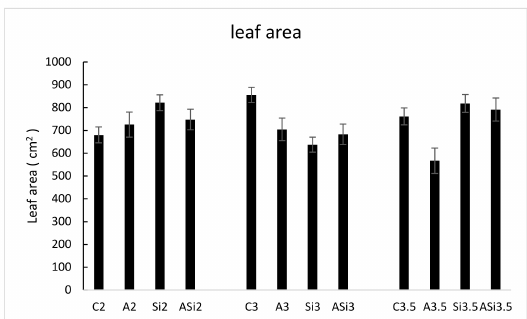
Figure 10. Leaf area at the end of the trial for the C2 (foliar application with water and fertigation EC 2.0 dS m − 1 ), A2 (foliar application with Arthrospira platensis and fertigation EC 2.0 dS m − 1 ), Si2 (foliar application with Si and fertigation EC 2.0 dS m − 1 ), ASi2 (foliar application with Arthrospira platensis and Si and fertigation EC 2.0 dS m − 1 ), C3.0 (foliar application with water and fertigation EC 3.0 dS m − 1 ), A3.0 (foliar application with Arthrospira platensis and fertigation EC 3.0 dS m − 1 ), Si3 (foliar application with Si and fertigation EC 3.0 dS m − 1 ), ASi3 (foliar application with Si and Arthrospira platensis , and fertigation EC 3.0 dS m − 1 ) treatments; C3.5 (foliar application with water and fertigation EC 3.5 dS m − 1 ), A3.5 (foliar application with Arthrospira platensis and fertigation EC 3.5 dS m − 1 ), Si3.5 (foliar application with Si and fertigation EC 3.5 dS m − 1 ), and ASi3.5 (foliar application with Si and Arthrospira platensis, and fertigation EC 3.5 dS m − 1 ) treatments. Di ff erent letters indicate significant di ff erences between treatments at the p < 0.05 level using the LSD test. Values are the means of 12 plants. Error bars show standard deviations.